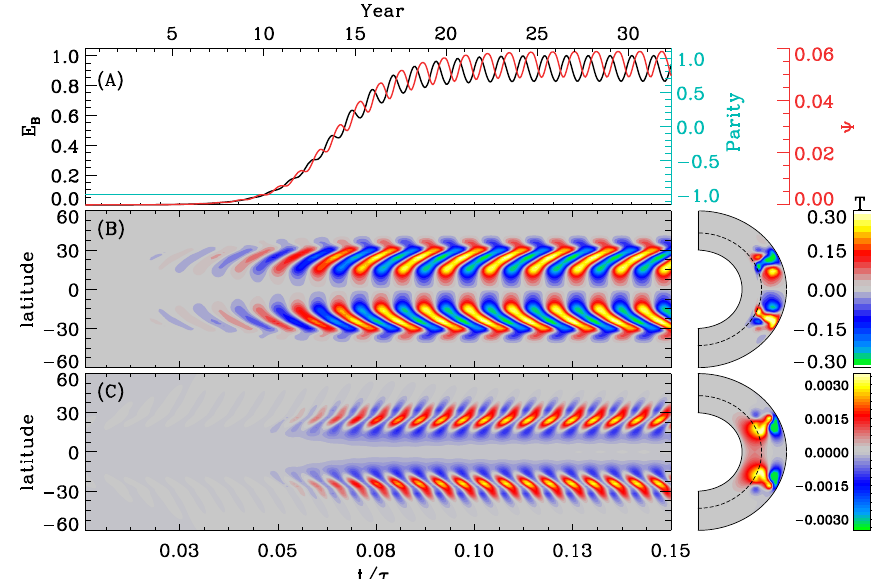
Fig. 3. Solution run 1, a non-kinematic dynamo solution in the Pm > 1 regime. Its de fi ning parameters are listed in the second line of Table 1. (A) Time series of normalized magnetic energy (black), integrated shear proxy (red), and equatorial parity (blue), starting from a seed magnetic fi eld and X 0 = 0 at t = 0. (B) Time-latitude diagram of the toroidal magnetic component extracted at r / R = 0.85, with a meridional plane snapshot at right. (C) Similar time-latitude diagram at r / R = 0.85 and meridional snapshot, but for the angular velocity perturbation normalized to the background angular velocity pro fi le, i.e., X 0 ( r , h , t )/ X ( r , h